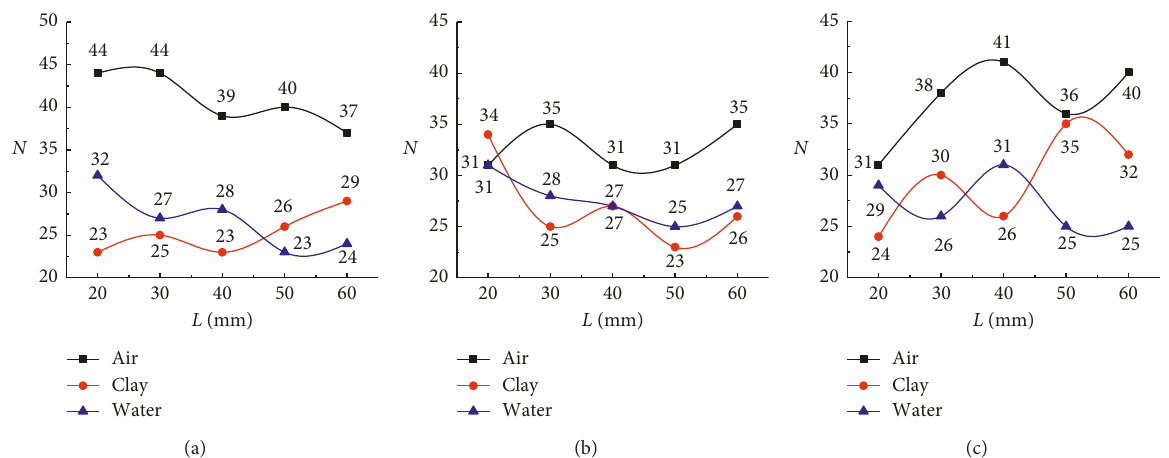
Figure 5: Relationship between fillings and the total number N of cracks. (a) θ � 0 ° ; (b) θ � 45 ° ; (c) θ � 90 ° .